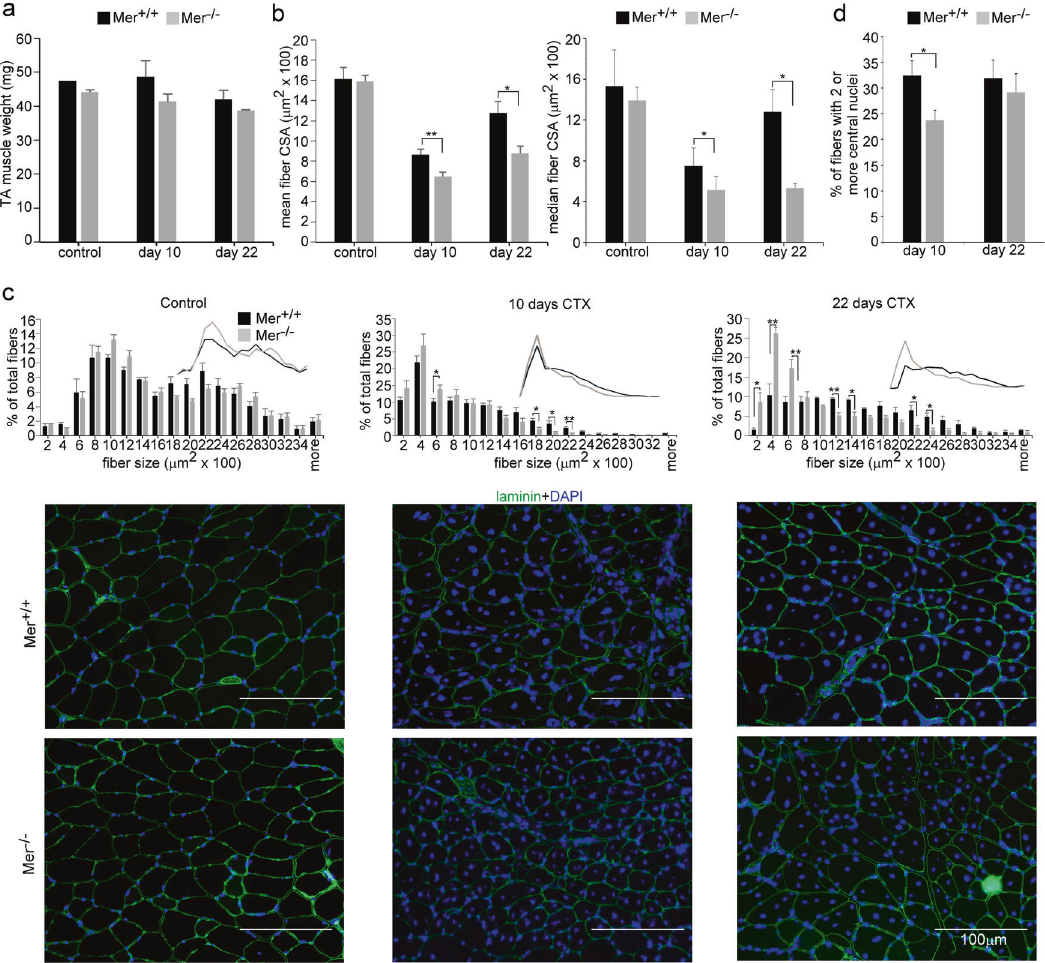
Fig. 1 Muscle regeneration is impaired in Mer − / − mice. Muscle injury was induced by injecting 50 μ l of 12 μ M cardiotoxin (CTX) into the tibialis anterior (TA) muscle of Mer + / + and Mer − / − mice. a Muscle weights, b mean and median myo fi ber cross-sectional areas (CSA), and c distribution of myo fi ber sizes in control TA muscles of Mer + / + and Mer − / − male mice, and at day 10 and 22 post-CTX – induced injury together with their representative immuno fl uorescence images of laminin (green) and DAPI (blue) nuclear staining. Scale bars, 100 µm. In total, 500 or more myo fi bers were analyzed in each sample using ImageJ software. Data are expressed as mean or median ± SEM. d Percentage of newly formed myo fi bers containing two or more central nuclei in TA muscles of Mer + / + and Mer − / − mice at day 10 and 22 post-CTX – induced injury. Data are expressed as mean ± SEM ( n = 6). Asterisks indicate statistical signi fi cance (* P < 0.05, Student ’ s t